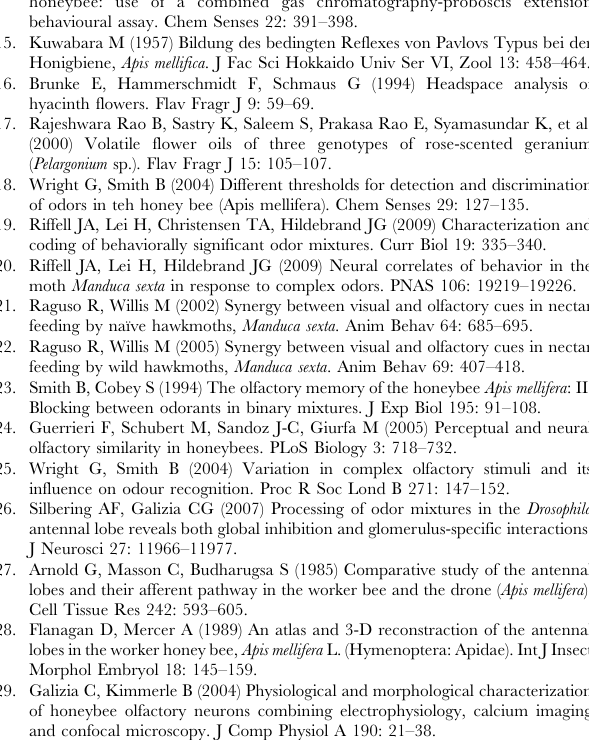
Table S1 Acquisition efficiency for odour mixtures